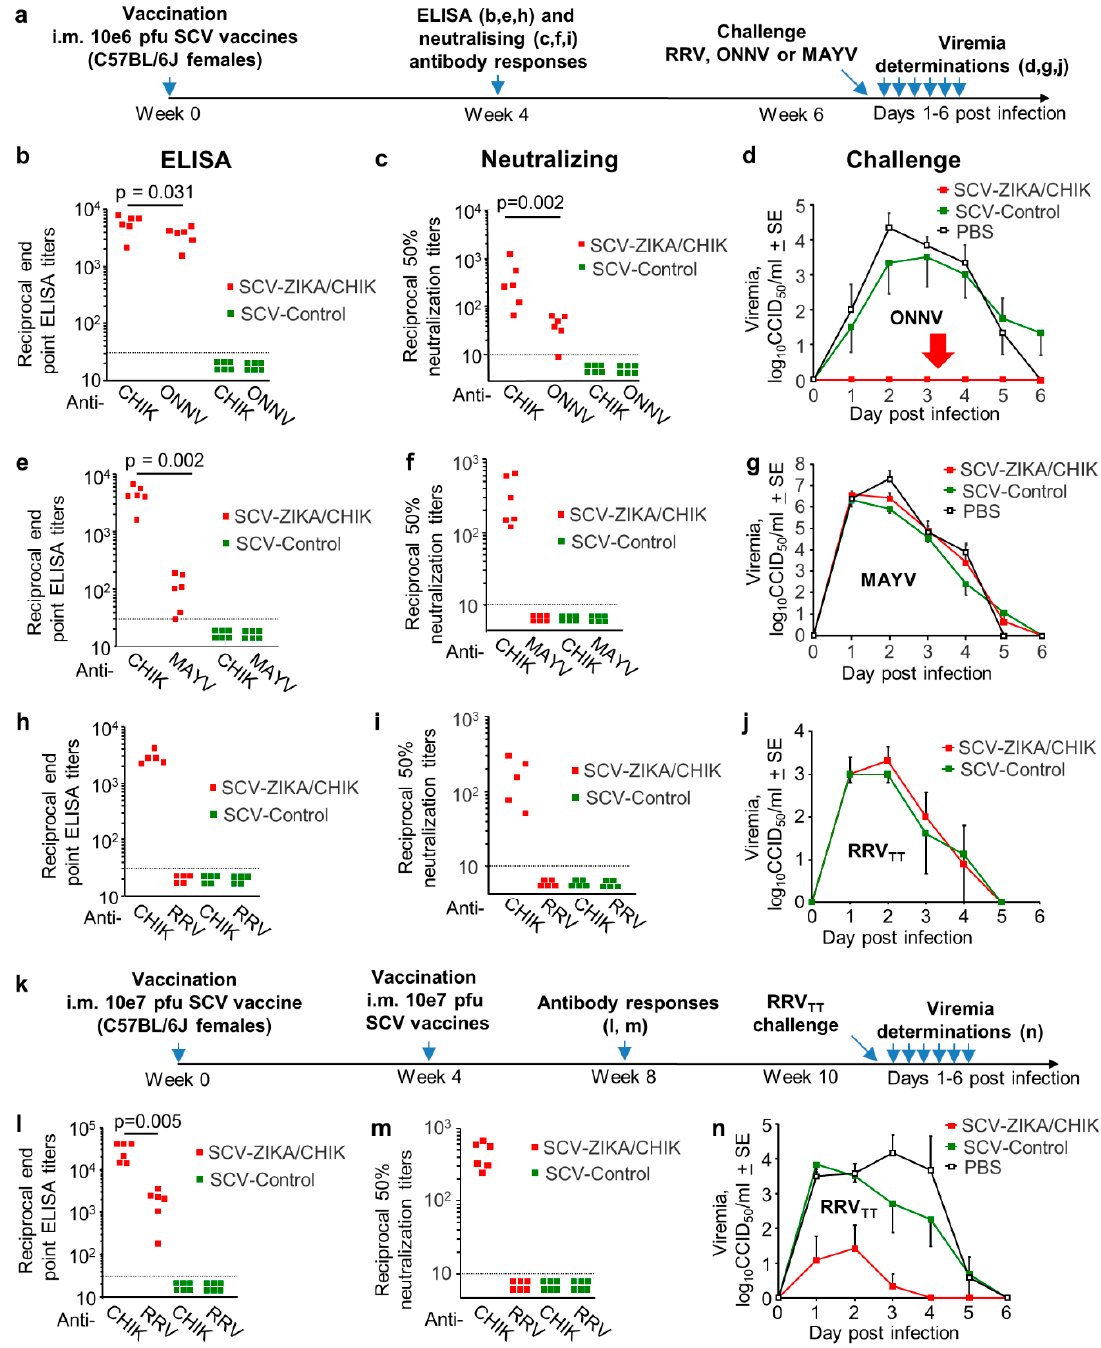
Figure 4. Cross-protection mediated by Sementis Copenhagen Vector (SCV)-ZIKA/CHIK vaccinations in wild-type mice. ( a ) Timeline of vaccination with a single dose of 10 6 pfu of SCV vaccines, antibody response determinations and challenge; ( b ) CHIKV and ONNV endpoint IgG ELISA titers four weeks post-vaccination with SCV-ZIKA/CHIK or SCV-Control (limit of detection 1 in 30); ( c ) CHIKV and ONNV 50% neutralization titers four weeks post-vaccination with SCV-ZIKA/CHIK or SCV-Control (limit of detection 1 in 10); ( d ) ONNV viremia post-challenge with ONNV in mice vaccinated with SCV-ZIKA/CHIK or SCV-Control or PBS (n = 6 mice per group). (Limit of detection for each mouse 2 log 10 CCID 50 /ml of serum.); ( e ) CHIKV and MAYV endpoint IgG ELISA titers four weeks post-vaccination with SCV-ZIKA/CHIK or SCV-Control; ( f ) CHIKV and MAYV 50% neutralization titers four weeks post-vaccination with SCV-ZIKA/CHIK or SCV-Control; ( g ) MAYV viremia post-challenge with MAYV in mice vaccinated with SCV-ZIKA/CHIK or SCV- Control or PBS (n = 6 mice per group); ( h ) CHIKV and RRV endpoint IgG ELISA titers four weeks post-vaccination with SCV-ZIKA/CHIK or SCV-Control; ( i) CHIKV and RRV TT 50% neutralization